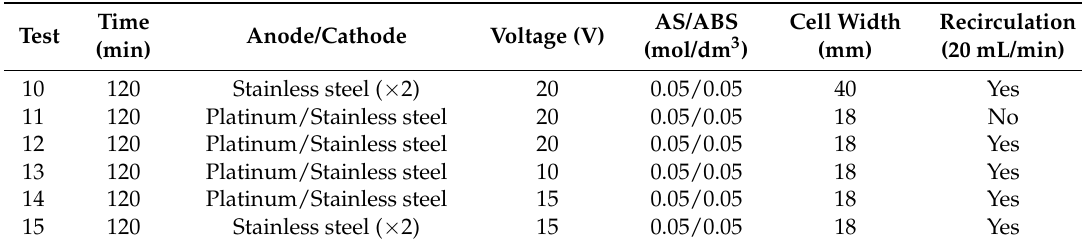
Table 5. Summary of the variation of experimental start parameters.